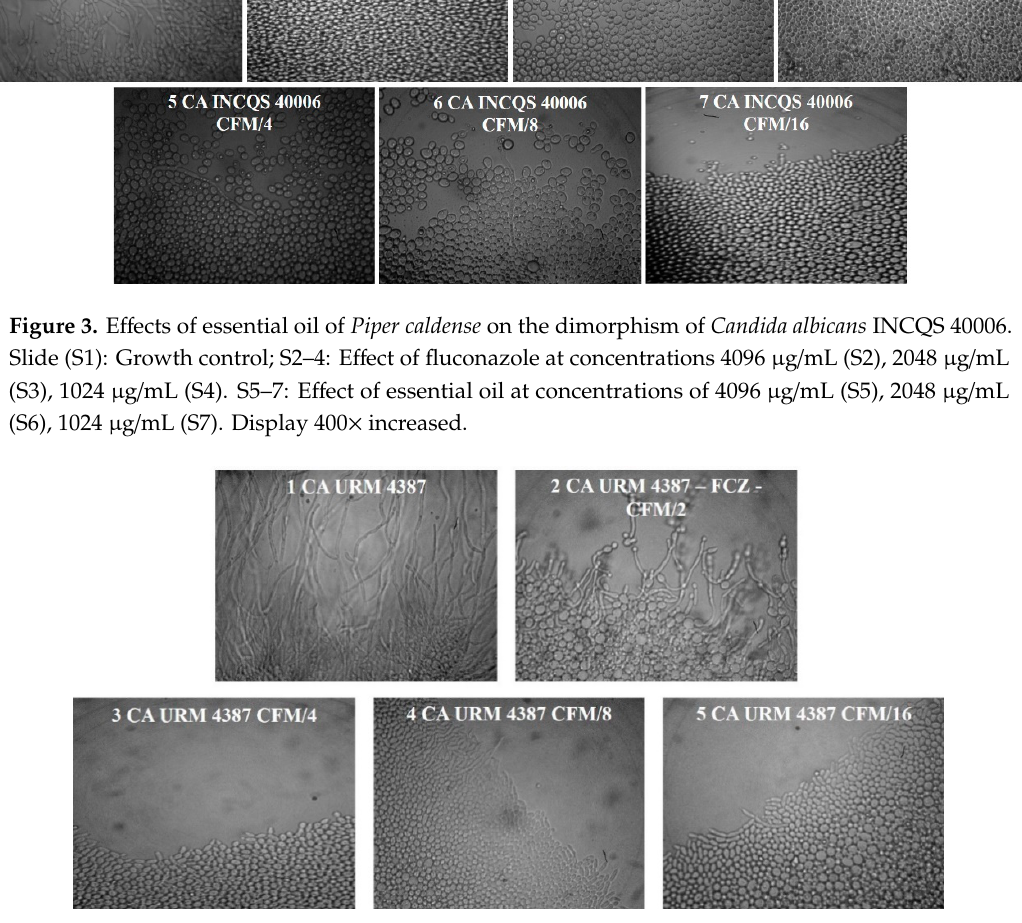
Figure 4. Effects of essential oil of Piper caldense on the dimorphism of Candida albicans URM 4387. Slide (S1): Growth control; S2: Effect of fluconazole at the concentration of 8 μ g/mL. S3–5: Effect of the essential oil at 2048 μ g/mL (S3), 1024 μ g/mL (S4), 512 μ g/mL (S5).